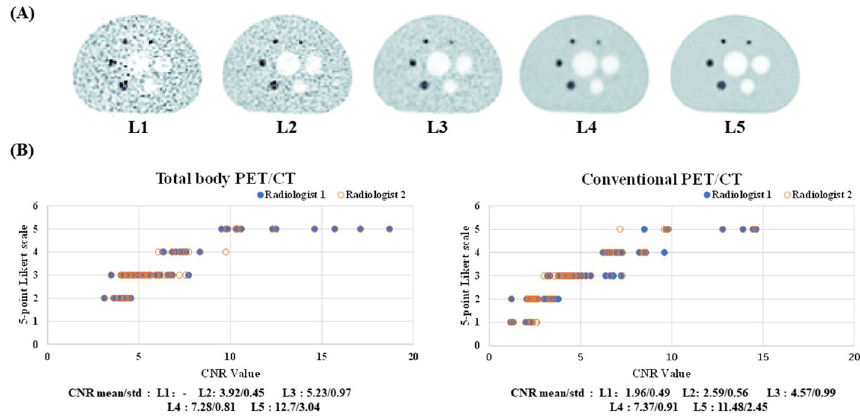
Fig. 4 Relationship between the objective indicator (CNR) and the subjective assessment (5-point Likert scale). A The reference example images of grades 1–5 in the 5-point Likert scale (L1: poor, L5: excellent). B Scatter plot for the CNR value vs. 5-point Likert scale upon the total body PET/CT scanner and the conventional short AFOV PET/CT scanner (derived from Siemens Biograph mCT scanner in this study), respectively. The 5-point Likert scale was independently rated by two nuclear radiologists in